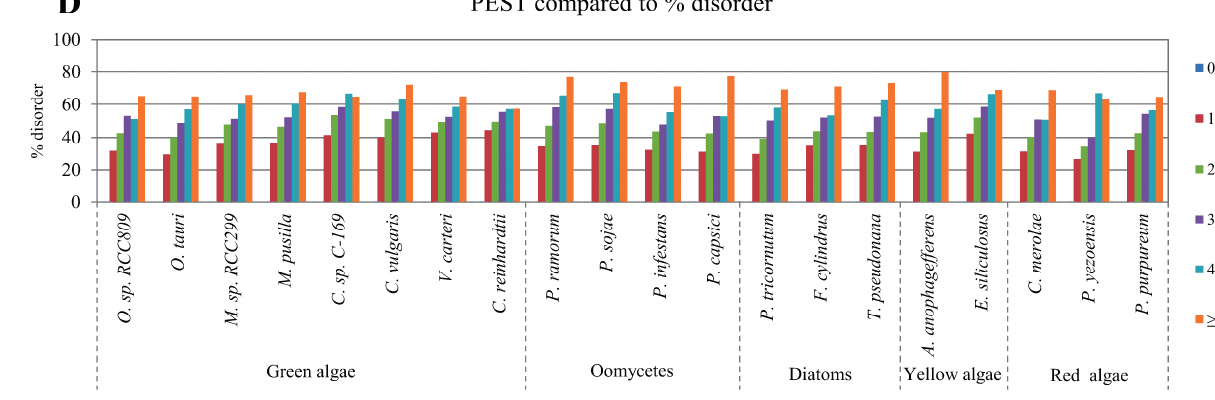
Figure 4. Correlation between disordered protein content and ubiquitination sites or PEST regions. Normalized predicted ubiquitination sites and PEST regions per 400 amino acids in the studied algae proteomes are presented in ( A , C ), respectively; Relative percentage of disordered protein content with different numbers of predicted sites of ubiquitination and predicted regions of PEST are presented in ( B , D ),